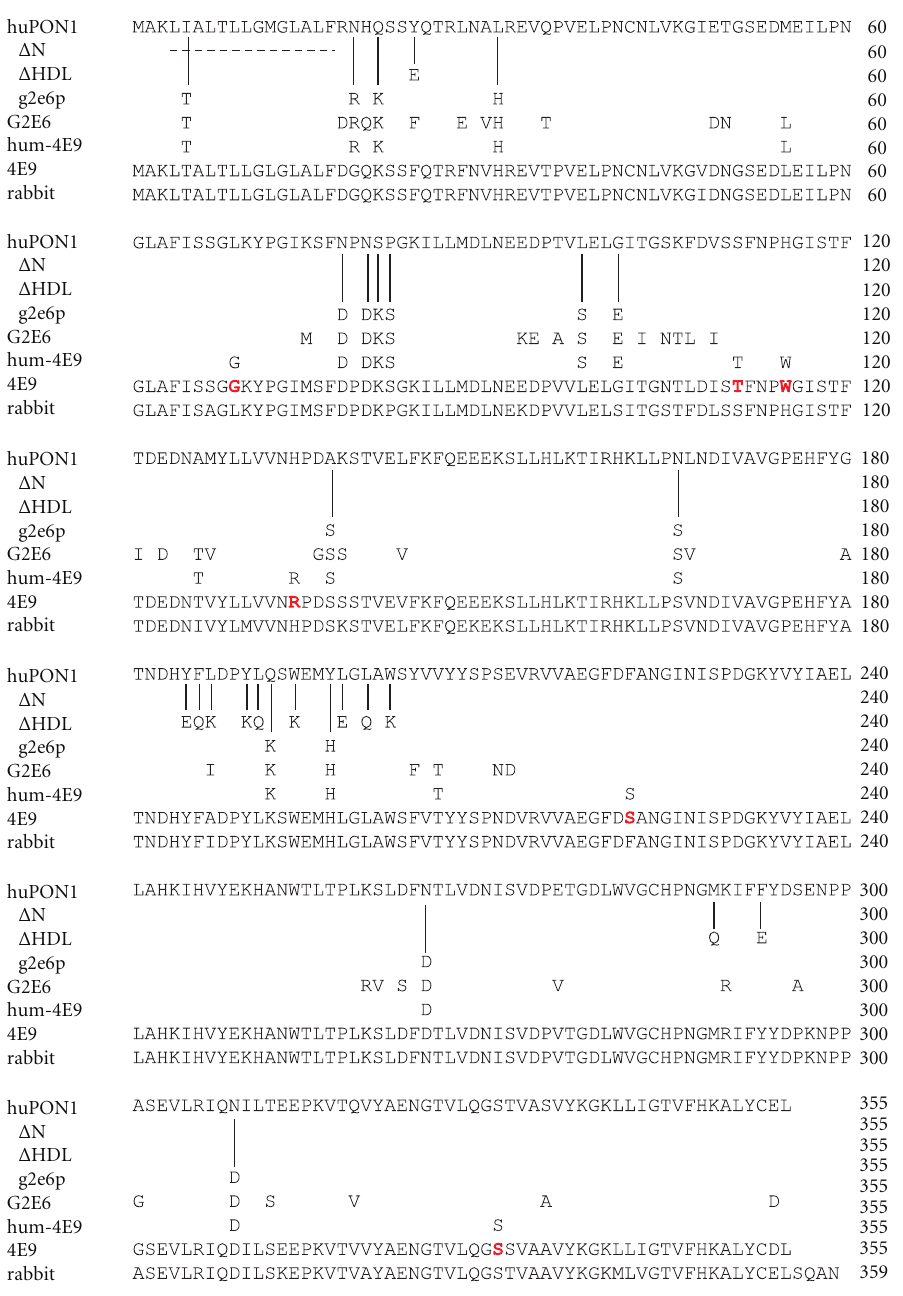
Figure 1: Alignment of PON1 variants. All di ff erences are noted with respect to the human PON1 sequences (Q192/M55 polymorph); the 4E9 sequence and the similar rabbit PON1 sequence are shown in full for reference. Di ff erences between G3C9 and 4E9 are noted in red in the 4E9 sequence. -: